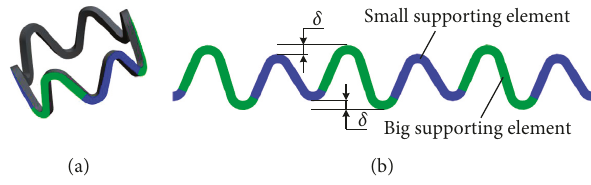
Figure 3: Schematic of the UHSR: (a) 3D UHSR; (b) 2D UHSR.